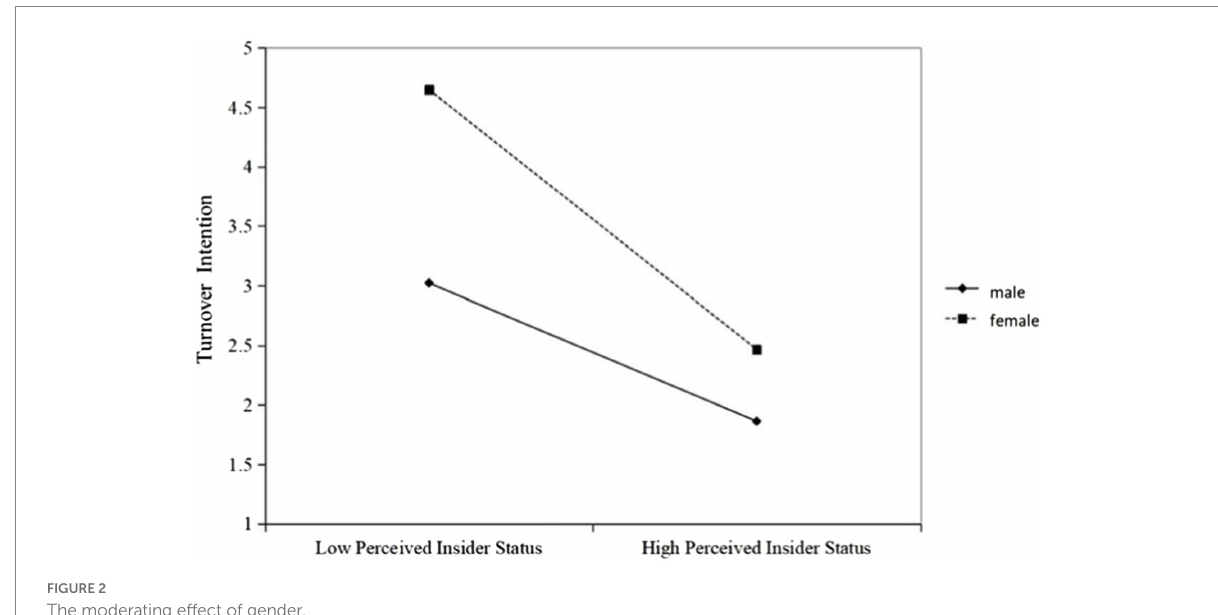
FIGURE 2 The moderating effect of